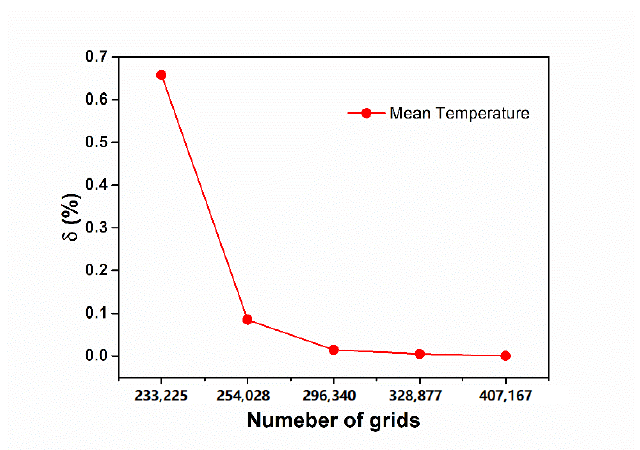
Figure 8. Relative errors of the mean temperature for different grid numbers when t = 1 s.